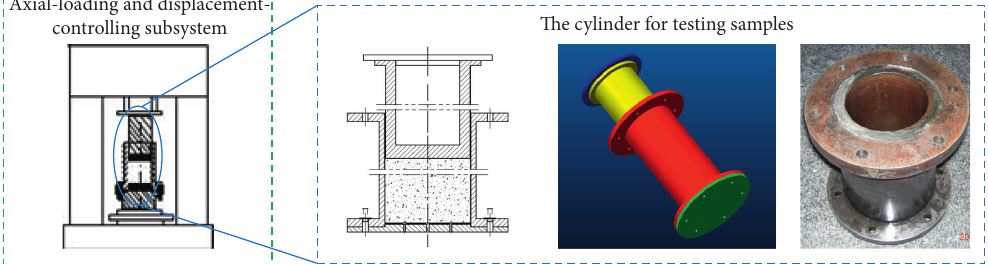
Figure 2: The compaction test system of crushed stone.